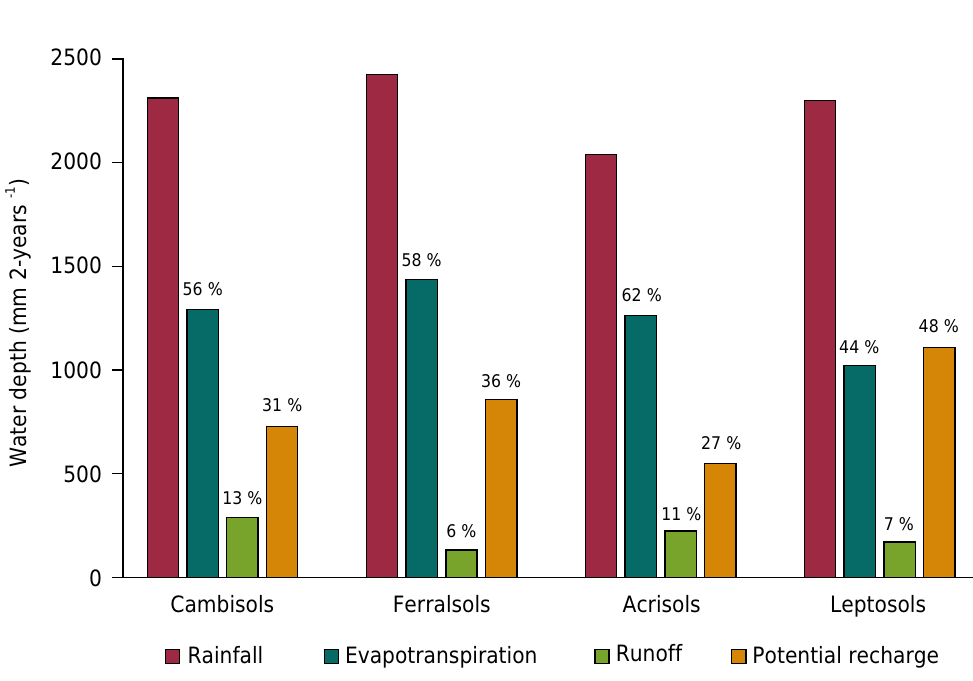
Figure 7. Mean values of the water balance components for the different soil classes for the two-year period from 2007-2009; the values in percentage refer to the (%) of rainfall in the water balance components (Potential recharge, Runoff,